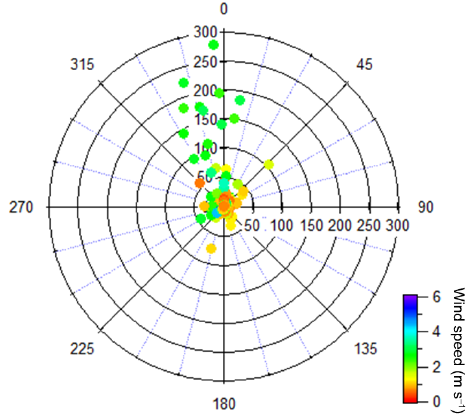
Figure 10. Pollution rose of factor 5 contribution (µgm − 3 ) in sum- mer.